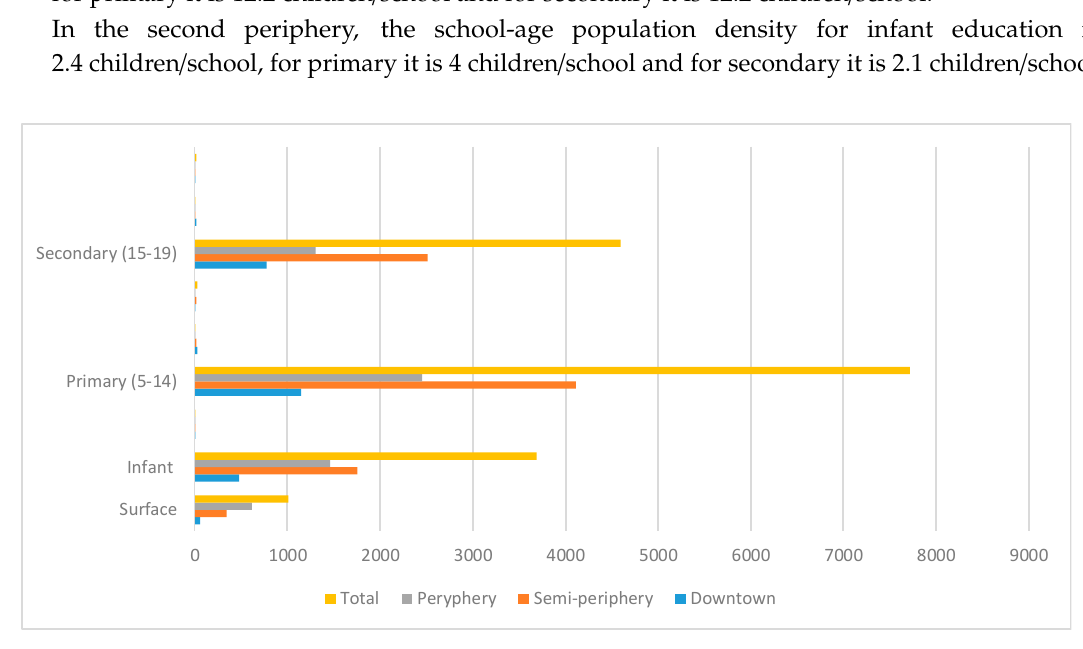
Table 1. Heritage distribution in city ′ s zones.